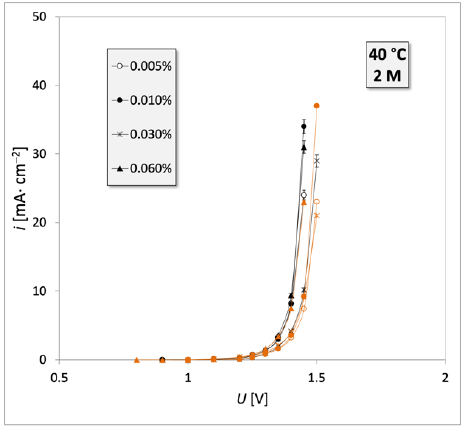
Figure 7. Electro-oxidation curves of Syntanol DS-10 detergent (orange lines) and waste engine oil emulsion (black lines) at the temperature of 40 °C in a 2 M aqueous solution of H 2 SO 4 , for various concentrations of detergent and emulsion (0.005%, 0.010%, 0.030%, and 0.060% of reactor volume).